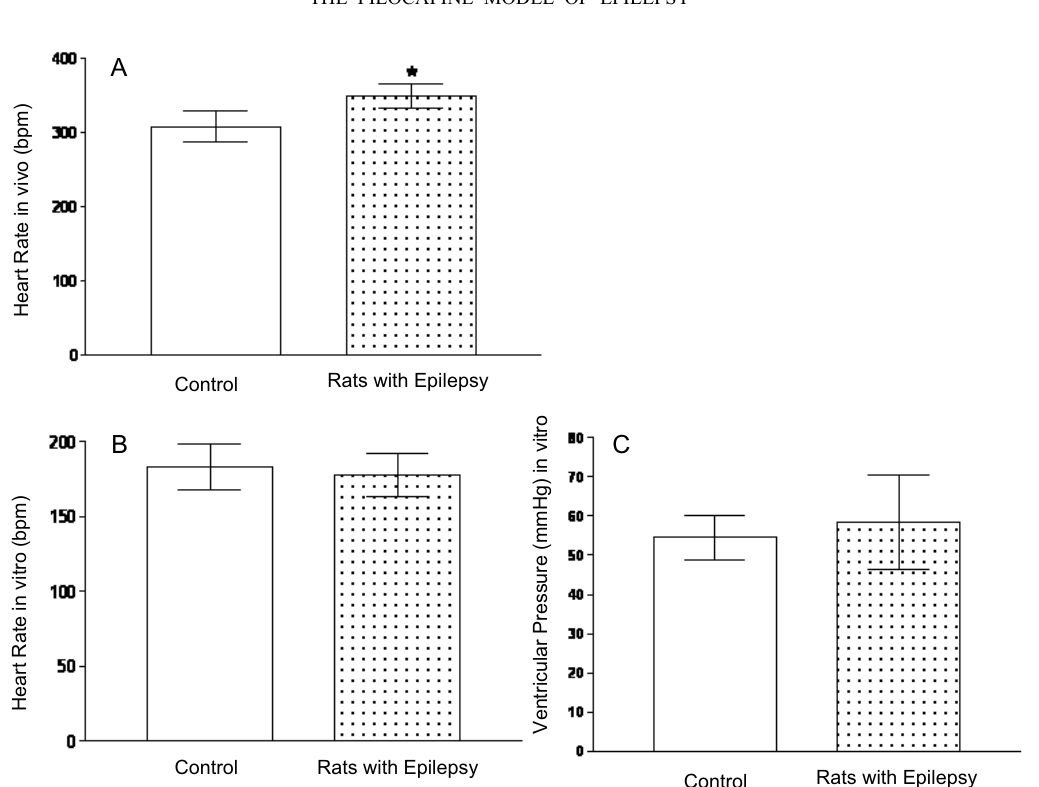
Fig. 3 – Results obtained by Colugnati et al. (2005). Heart rate in vivo (A); Heart rate of isolated ex vivo preparation (B); Ventricular pressure of isolated ex vivo situation (C) from control and rats with epilepsy. Note that heart rate in vivo is significantly higher in rats with epilepsy. *p < 0 .